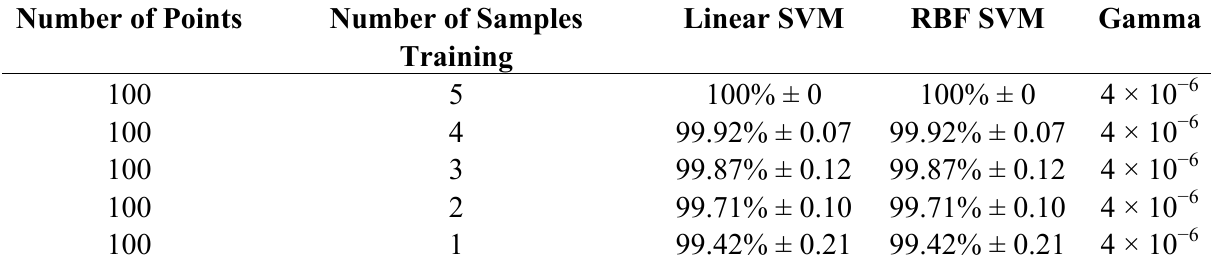
Table 6. Success rates for SVM with 144 GPDS users for 60 DHMM states and 100 edges coding points, decreasing the training